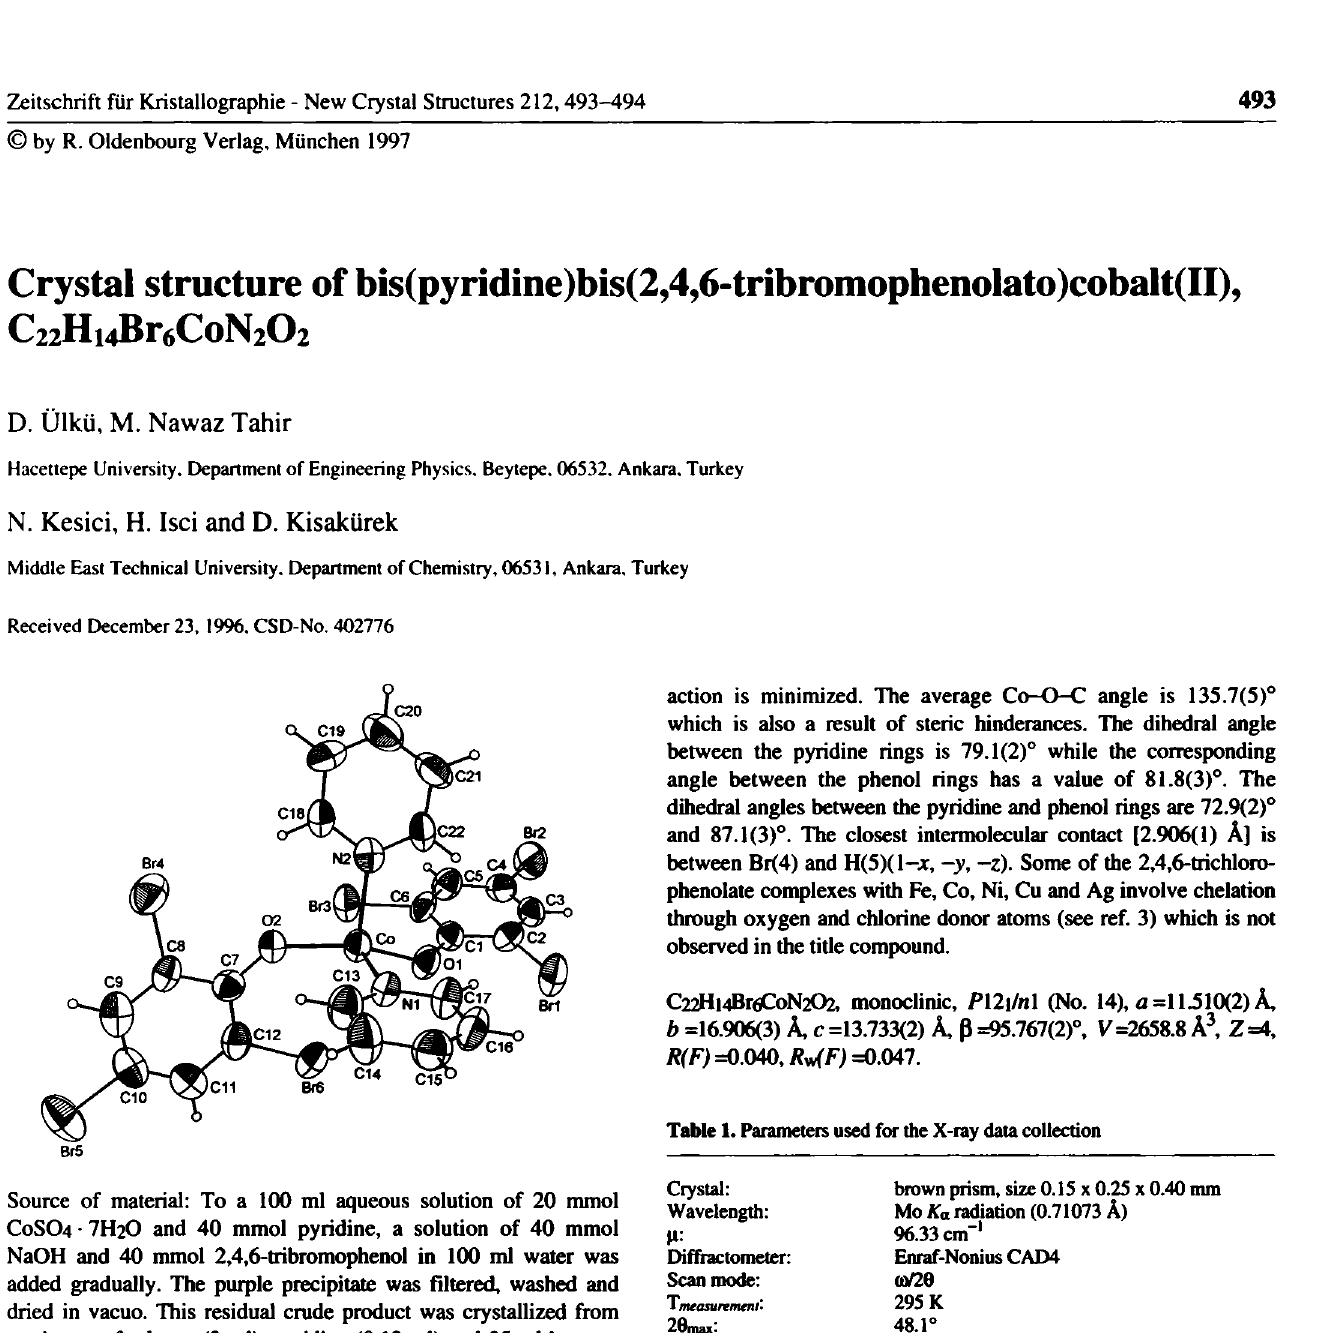
Table 2. Final atomic coordinates and displacement parameters (in Â 2